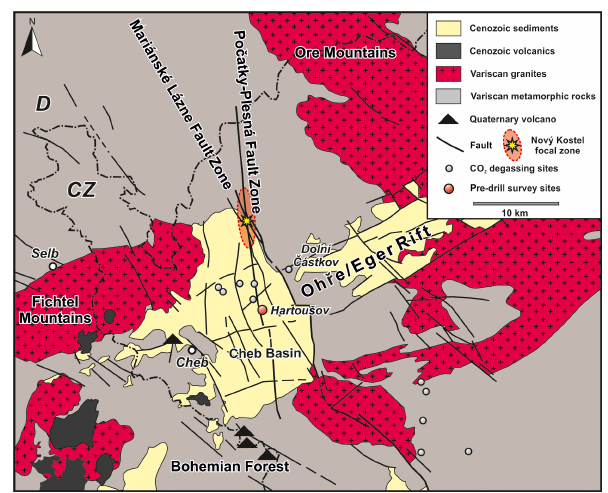
Figure 1. Geological map of the Cheb Basin and surroundings, based on Flechsig et al. (2008) and Dahm et al. (2013).